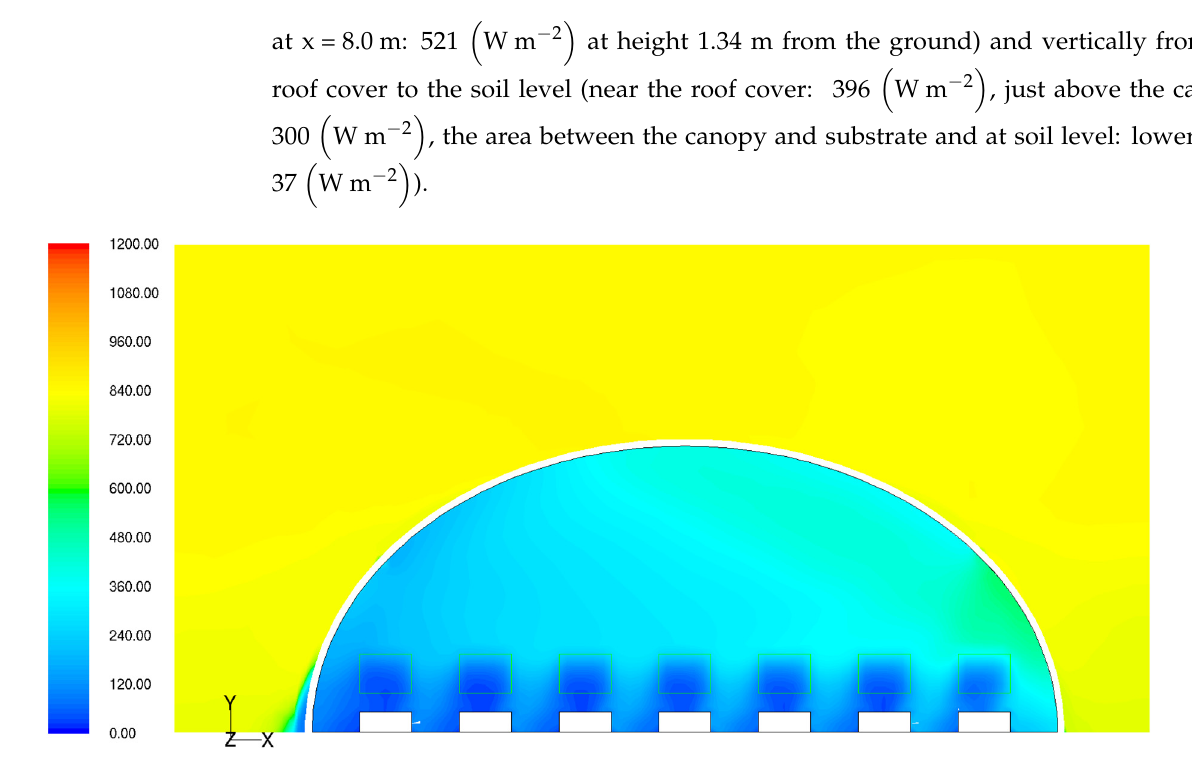
Figure 6. Solar incident radiation field (W m (cid:2879)(cid:2870) ) at a distance z = 19 m from the door of the studied greenhouse.